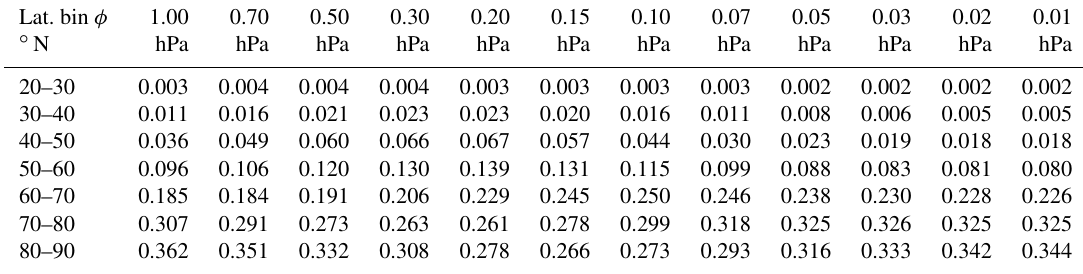
Table A2. Normalized latitudinal distribution (cid:57)(φ,z) of EPP-NO y densities and fluxes in NH winters as a function of pressure level. Lat. bin φ